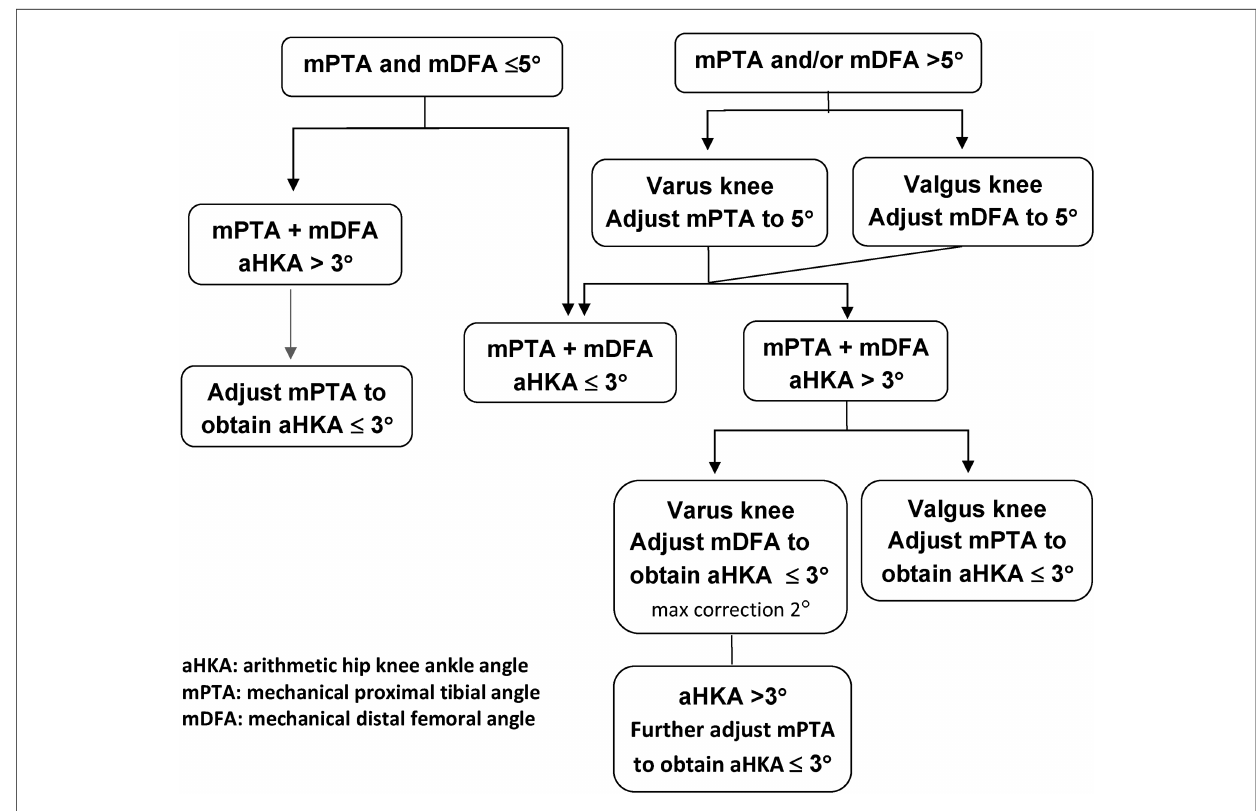
FIGURE 2 rKA algorithm as proposed by Vendittoli (6,